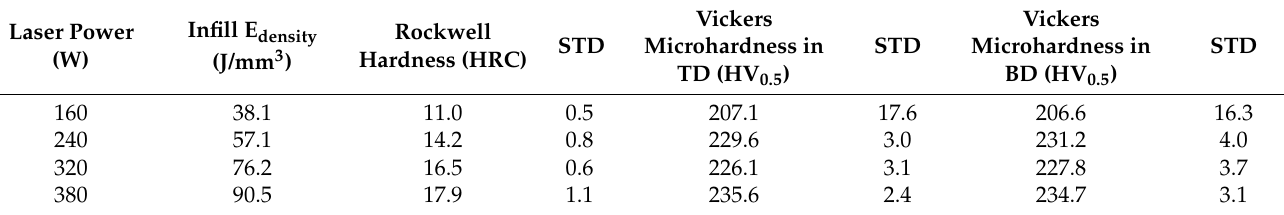
Table 3. Average hardness values of as-built 316LSS.